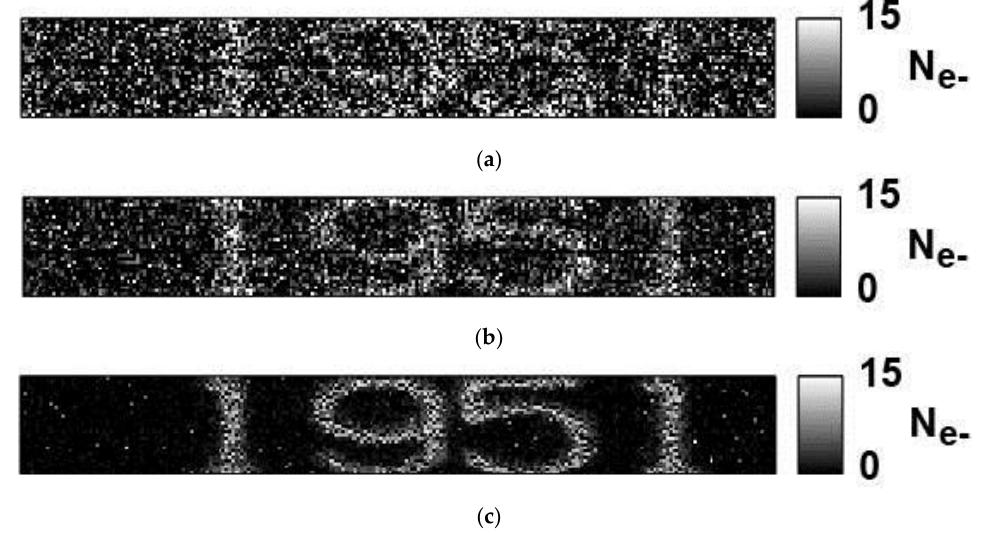
Figure 16. Low-light-level images with three different CMS gains ( M = 2, 16, and 128). ( a ) M = 2, noise (median): 2.4 e − rms ; ( b ) M = 16, noise (median): 1.1 e − rms ; and ( c ) M = 128, noise (median): 0.29 e − rms .